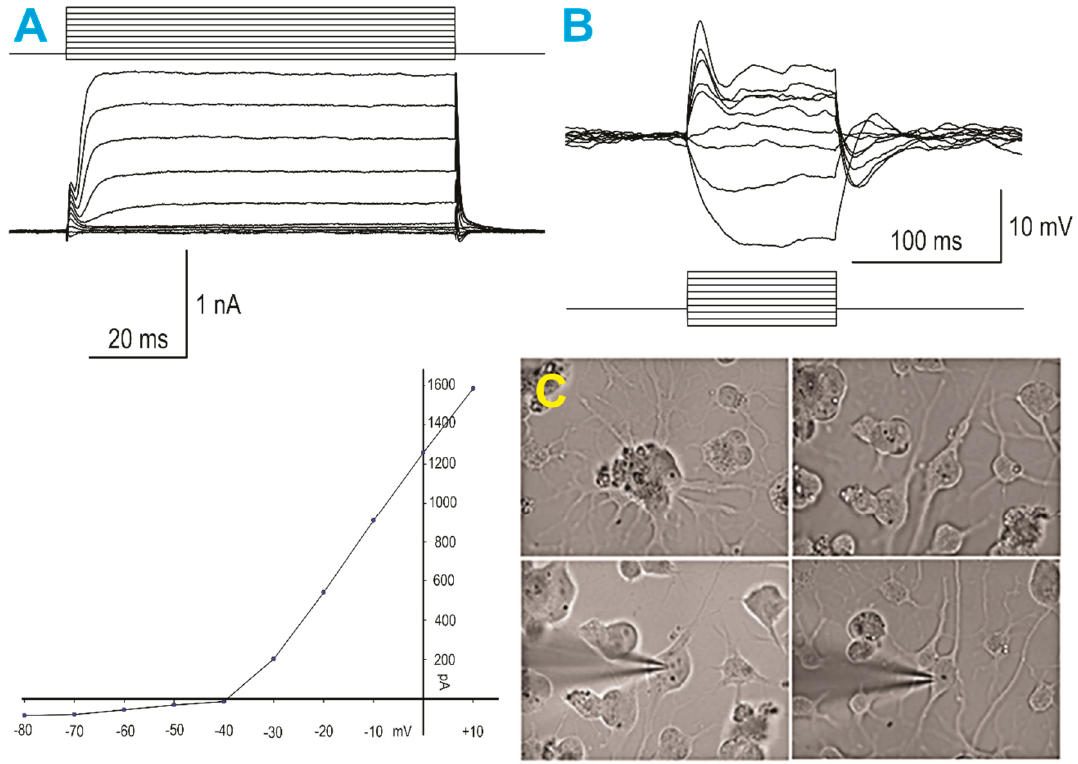
Figure 4. SPC-NSCs gave rise to neurons after space flight. ( A )—(left panels) Whole-cell voltage clamp recording using K-gluconate in the internal solution: (top) step voltage commands from –80 to +10 mV elicited only minimal inward currents, whereas outward currents were predominant, and (bottom) graph represents an IV relationship, illustrating the presence of large outward currents starting at –30 mV. ( B ) When the recording was switched to current clamp mode, small step current pulses evoked large negative voltage deflections and only an incipient action potential with depolarizing current injections, demonstrating a neuronal phenotype, yet still very immature. ( C ) Infrared video-microscopy images of human neurons derived from NSCs flown into space. The top left panel shows a cluster of cells with multiple processes emanating from different cells. The top right panel shows an NSC with bipolar morphology. The bottom left panel shows the same cell after patch and electrophysiological recordings (illustrated in A and B) were obtained. The bottom right panel shows another NSC after patching.